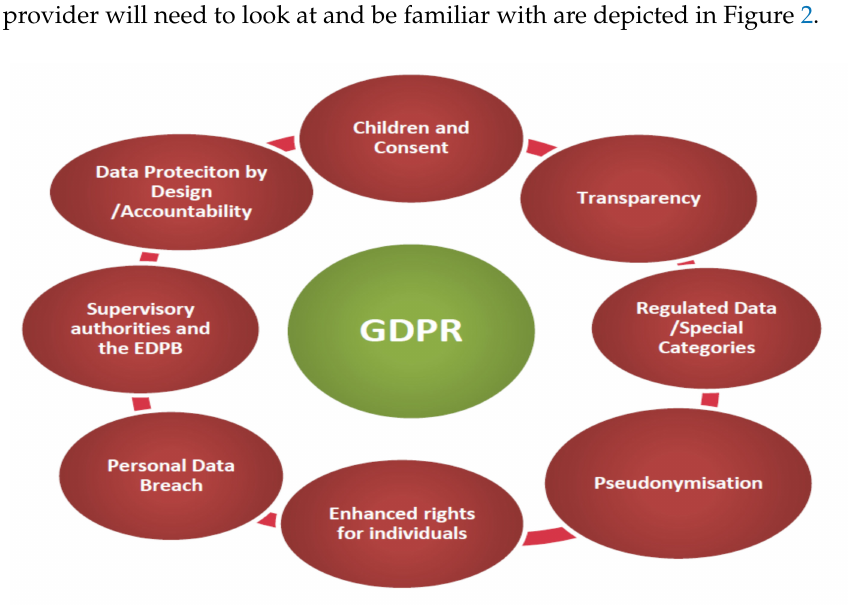
Figure 2. GDPR changes via the